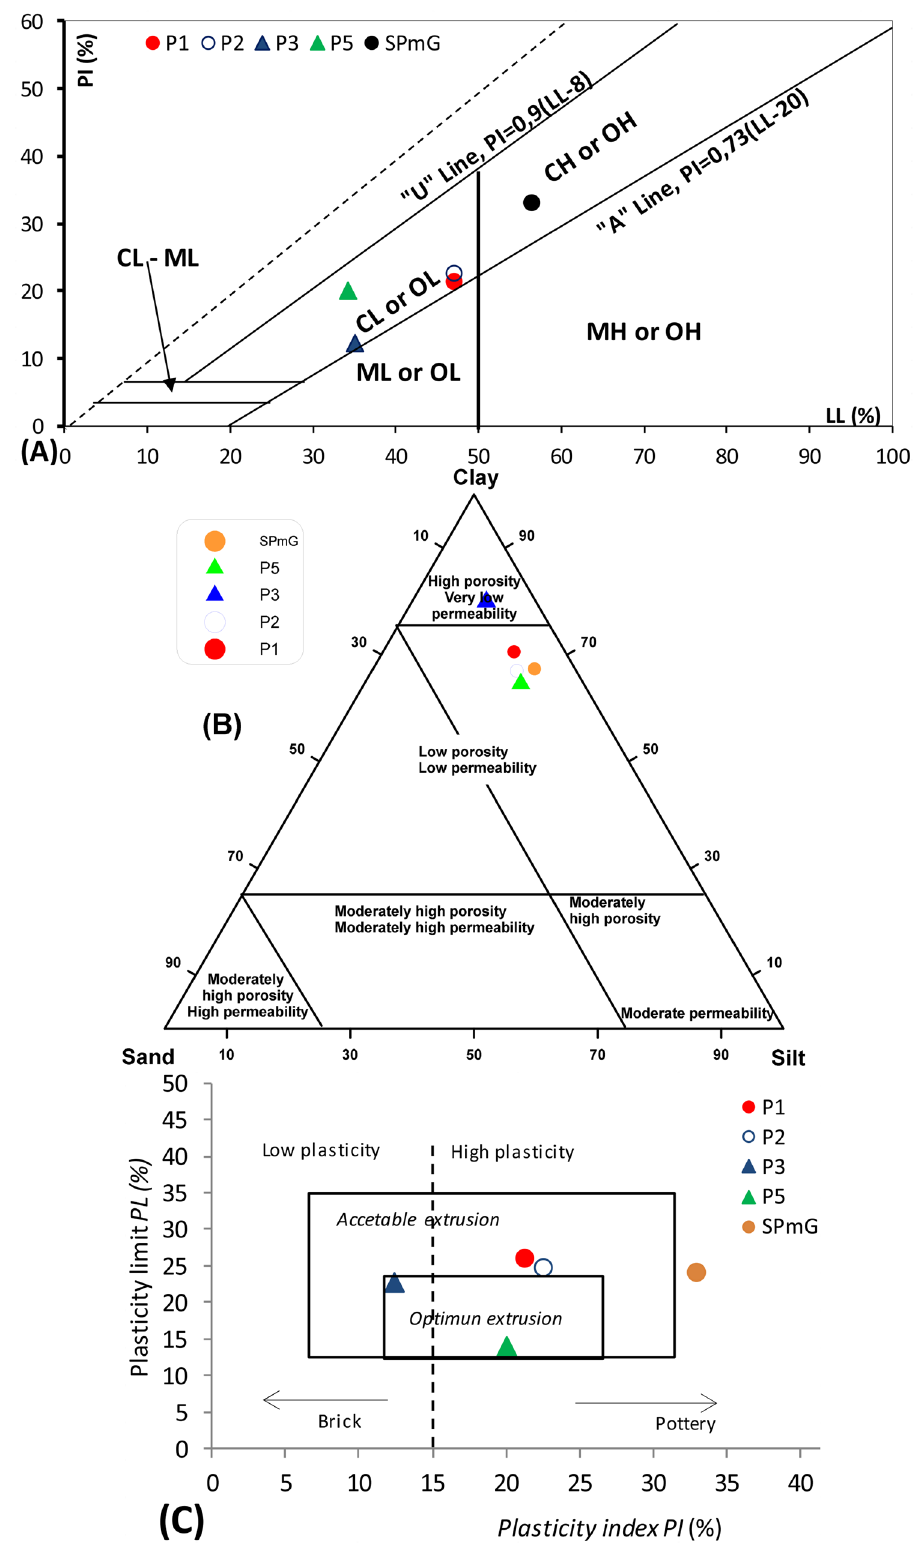
Fig. 3 Position of Boulgou soils in some empirical diagrams: a Casagrande chart (USCS classification): Clay (C), Silt (M), Organic (O): Low plasticity (L), High plasticity (H); b Triangu- lar diagram of porosity and permeability (McManus [18]); c Diagram of Bain and Highley [21] showing samples accept- able (P1, P2) or optimum (P3, P5) in extrusion